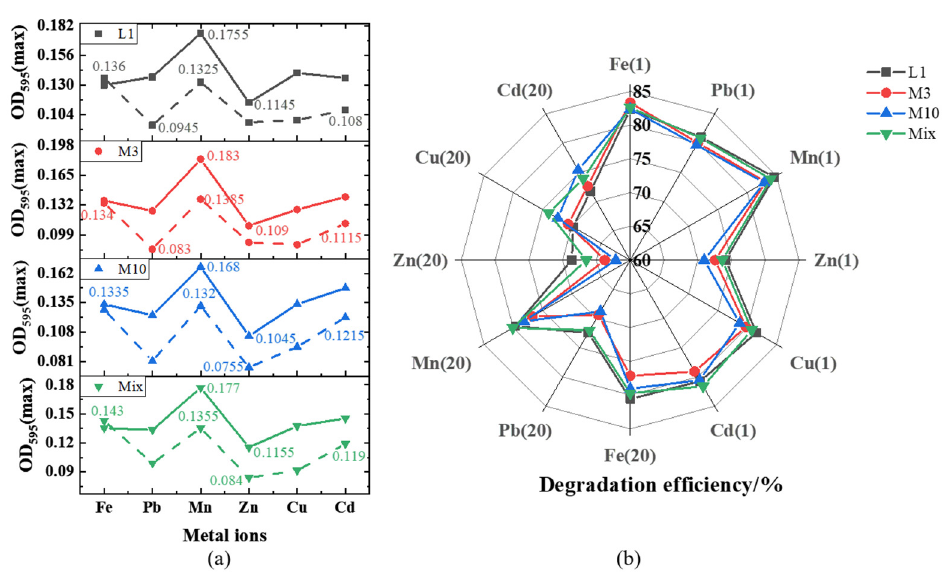
Figure 4. Effect of metal ions on degrading bacteria. The ( a ) maximum cell density of strains and ( b ) the yield of MTBE degradation with various metal ions, the concentrations of metals were controlled at 1 mg/L (dotted line) and 20 mg/L (solid line), respectively.